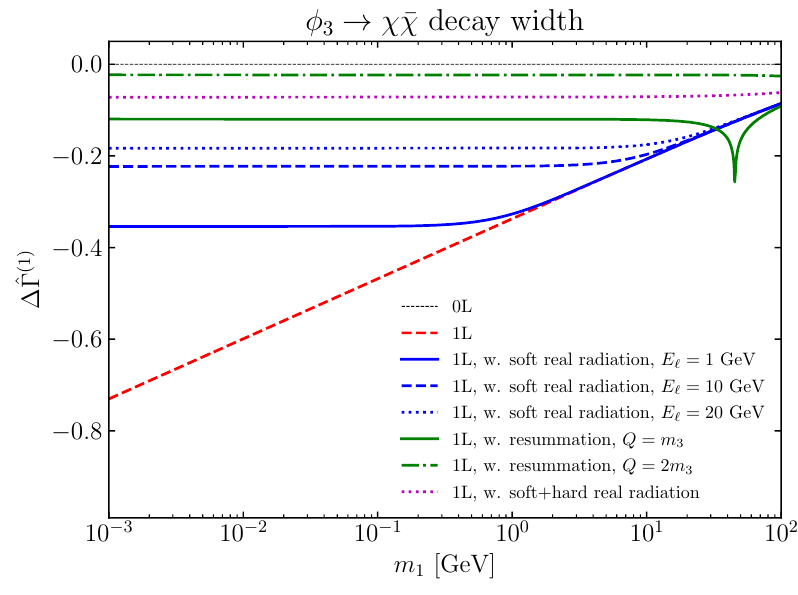
Figure 6. Size of the one-loop external φ 3 leg correction to the φ 3 → χ ¯ χ decay width in the toy model of section 2, relative to the tree-level result, as a function of m 1 . Black: tree-level result only; red: one-loop result; blue: one-loop result, including soft real φ 1 radiation (with different choices for the detector energy resolution E ‘ ); purple: one-loop result, including both soft and hard real φ 1 radiation; green: one-loop result, including a resummation of φ 1 contributions (with different choices of the renormalisation scale Q ). For simplicity, we set all trilinear couplings to zero except A 123 , which we take to be A 123 = 3 TeV. The other parameters of the model are taken to be y 3 = 1 , m 2 = m 3 = 1 TeV, m χ = 200 GeV, λ 1122 = 0 . 25 , λ 1133 = 0 . 4